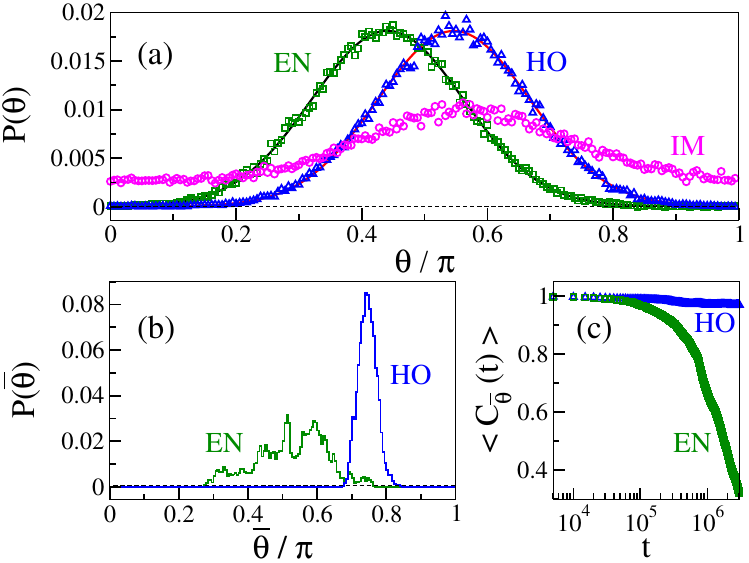
Figure 6. Steady state characteristics of high density states. ( a ) Orientation distribution P ( θ ) of particles calculated from one snapshot in the steady state. P ( θ ) fits with Gaussian distribution (continuous lines) for both the HO and the EN states. The IM state shows broad distribution of θ . ( b ) Distribution of the mean orientation P ( θ ) calculated from θ of each snapshot in the steady state. P ( θ ) is broad for the EN state in comparison to the HO state. ( c ) Steady state autocorrelation C θ ¯ ( t ) of the mean orientation of the system. All plots are shown for ( βε , C ) = (2.0,